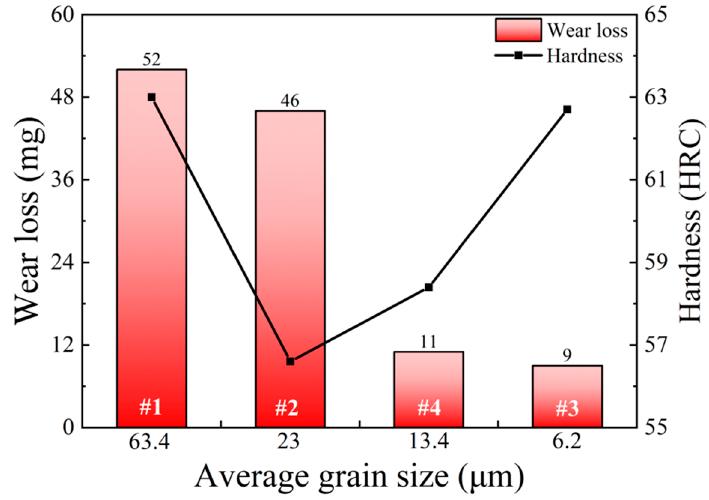
Figure 17. Relationships among wear loss, hardness and average grain size.